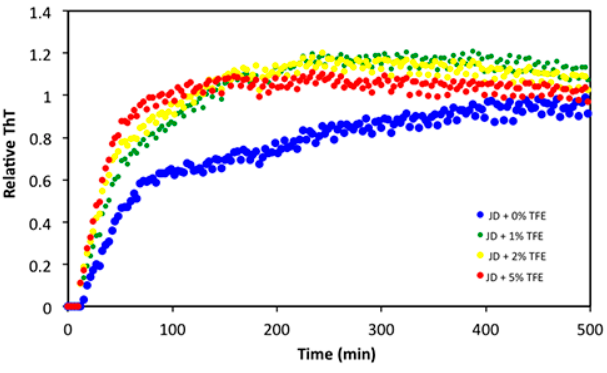
Figure 9. Aggregation kinetics of 40 µM JD in the presence of different TFE concentrations ( v / v ). The aggregation was monitored following the ThT fluorescence signal at 37 °C for 500 min ( λ ex: 445 nm; λ em: 535 nm).